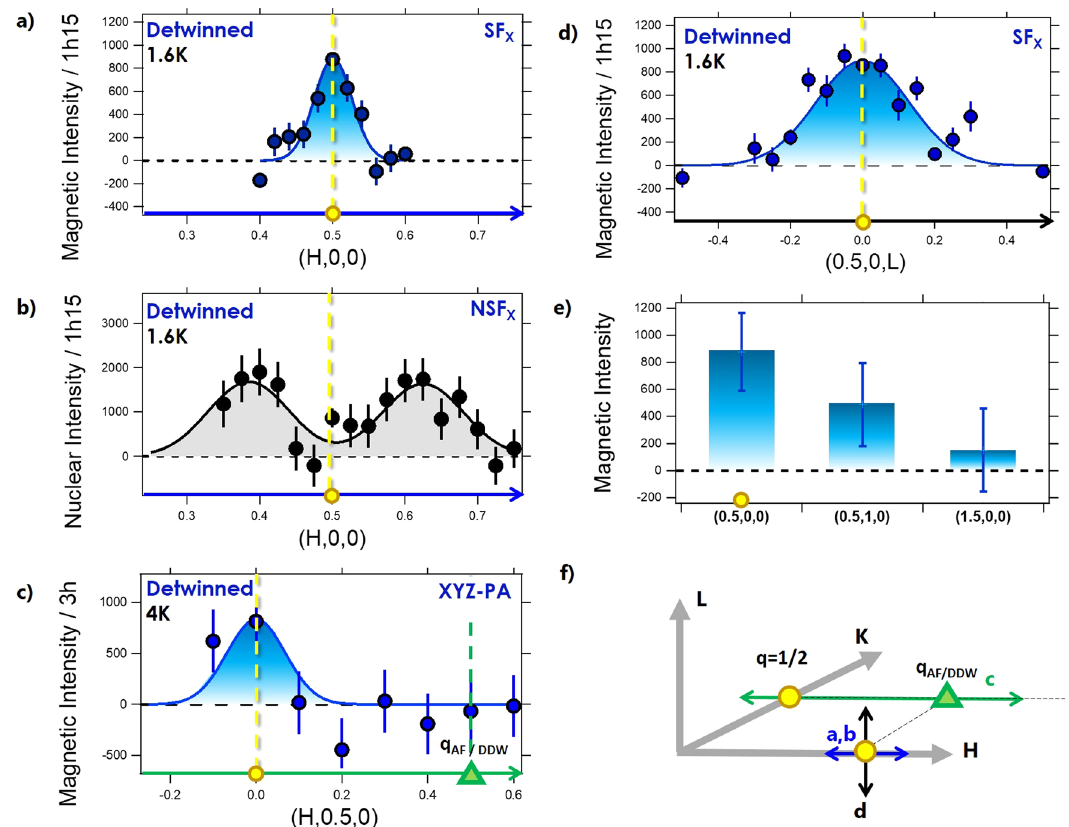
Fig. 2 Biaxial planar short-range magnetism in twin-free YBa 2 Cu 3 O 6.6 (YBCO-d). a Background subtracted scan along ( H ,0,0) in the spin- fl ip (SF X ) channel. The magnetic intensity appears as a Gaussian signal centered at (0.5,0,0). b Background subtracted scan along ( H ,0,0) in the non-spin- fl ip (NSF X ) channel showing the nuclear scattering from the (Ortho-VIII) type chains superstructure. c Scan along Q = (H,0.5,0) obtained through XYZ polarization analysis (XYZ-PA) showing a magnetic signal centered at H = 0. d Background subtracted scan along Q = (0.5,0, L ) in the spin- fl ip ( SF X ) channel. The magnetic intensity appears as a Gaussian signal centered at (0.5,0,0). e Magnetic intensity resulting from XYZ-PA at different wave-vectors in the reciprocal space: (0.5,0,0), (0.5,1,0) and (1.5,0,0). f 3D representation of the reciprocal space showing the momentum scans performed in a – d . Data in a , b , d , e were measured on IN22 at 1.6K with the sample aligned in the (1,0,0)/(0,0,1) scattering plane. Data in c were measured on 4F1 at 4K with the sample aligned in the (1,0,0)/(0,1,0) scattering plane. Lines are fi ts by a sum of Gaussian peaks to the data. Error bars represent one standard deviation. Raw data are given in Supplementary Fig.